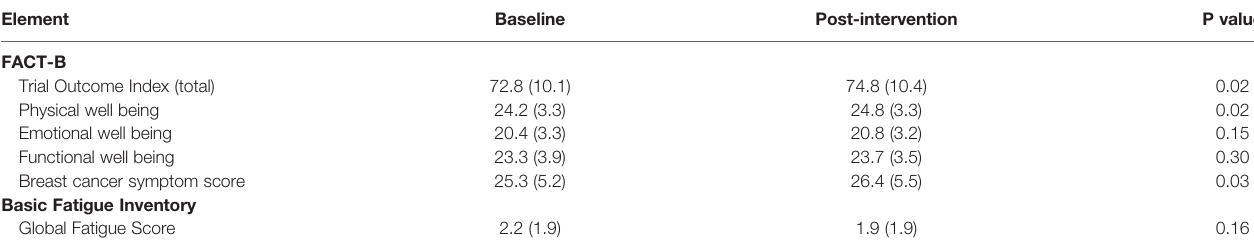
TABLE 3 | Comparison of patient reported outcomes at baseline and post-intervention.